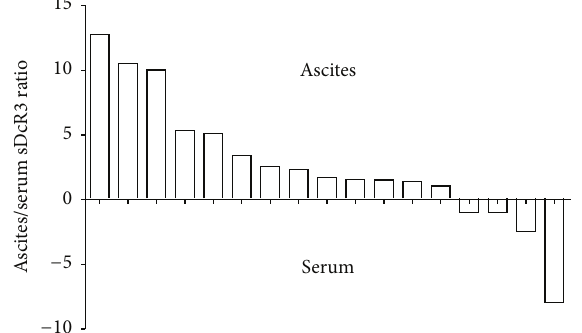
Figure 3: DcR3 protein is abundantly detected in ascitic fluid of cir- rhotic patients. Serum and ascitic fluid were concomitantly obtained from individual patients with cirrhosis and the concentration of DcR3 was measured by ELISA in both. The ascites-to-serum ratio was determined. Each bar shown in the graph corresponds to a single